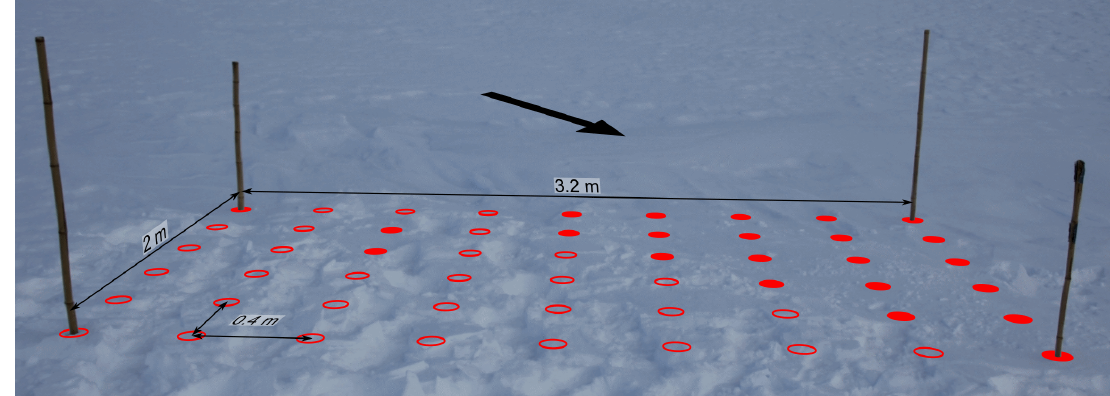
Figure 5. View of one of the rectangular SMP plots in group D in Fig. 3 in which measurements were performed on 29 December. The red circles indicate the regular grid with a spacing of 40cm where SMP measurements were performed. Empty circles stand for a SMP hardness below 1N and full circles for a SMP hardness above 4N. All remaining 74 SMP measurements acquired on that day show a SMP hardness below 1N. The arrow shows the approximate wind direction based on the erosion features visible behind the rectangle.